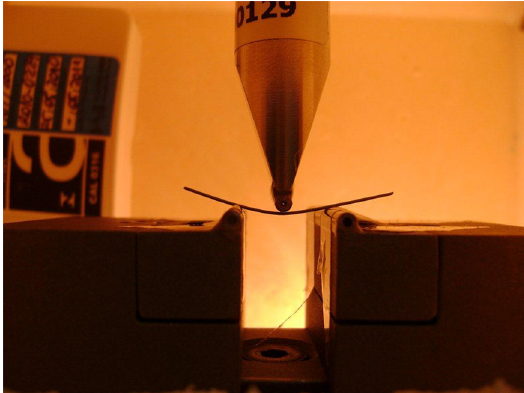
Figure 3. Experimental setup of a superelastic NiTi 0.014-in inch orthodontic archwire with 30 mm length under a 3-point bending test on an universal machine at 37